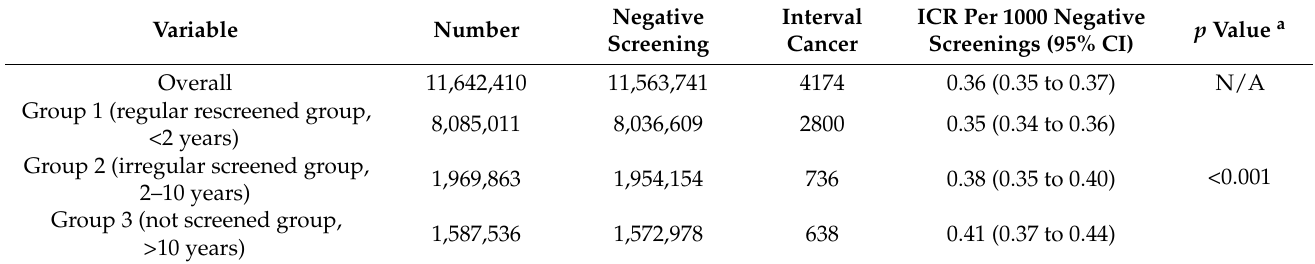
Table 2. Overall interval cancer rates with 95% confidence intervals arranged